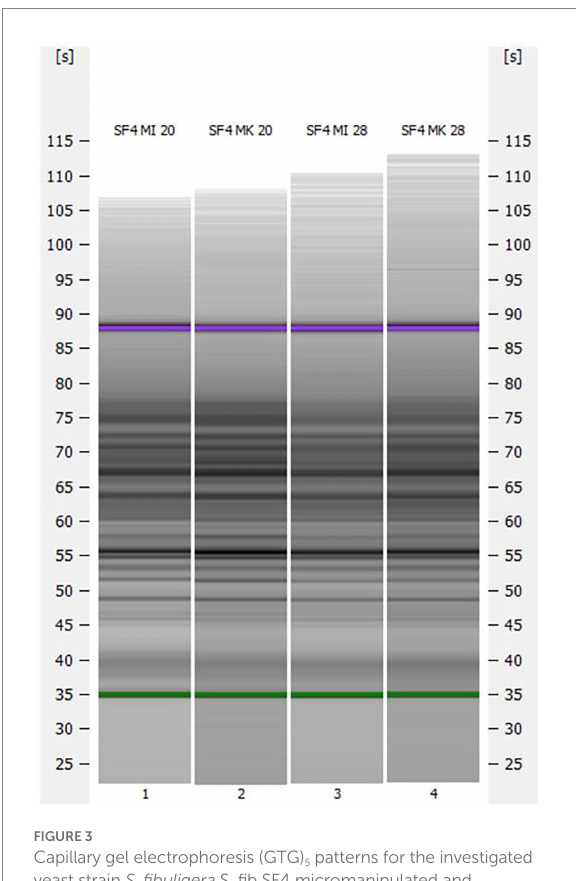
FIGURE 3 Capillary gel electrophoresis (GTG) 5 patterns for the investigated yeast strain S. fibuligera S. fib SF4 micromanipulated and propagated at 20 ° C (SF4 MI 20) and 28 ° C (SF4 MI 28) and the